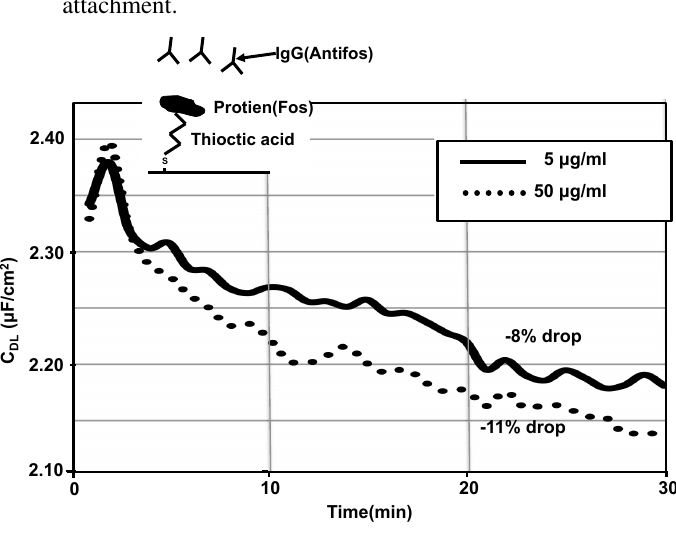
and 50 µg anti-FoS (IgG) mL mL mL